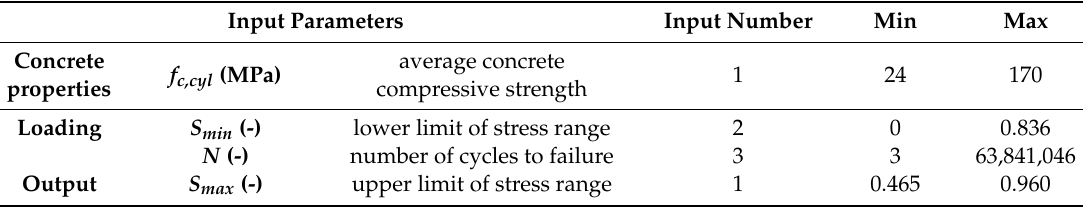
Table 2. Overview of input and output variables in the dataset, including ranges of